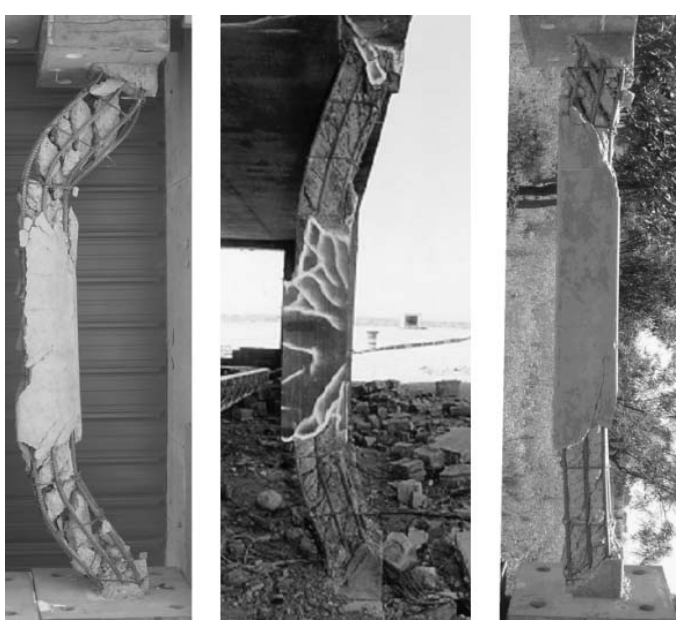
Fig. 6. As-built columns tested in the fi eld (center) and in the laboratory (left and right) at different impulse levels (increasing from right to left)